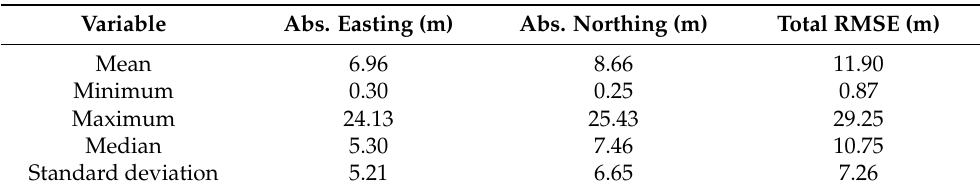
3 August (F-04) flight lines. While, the northwest river shows variable RMSE with seven PGCPs showing above 14 m error (Figure 11B), a RSME below 14.60 m is reported along the southeast riverbed (Figure 11C).